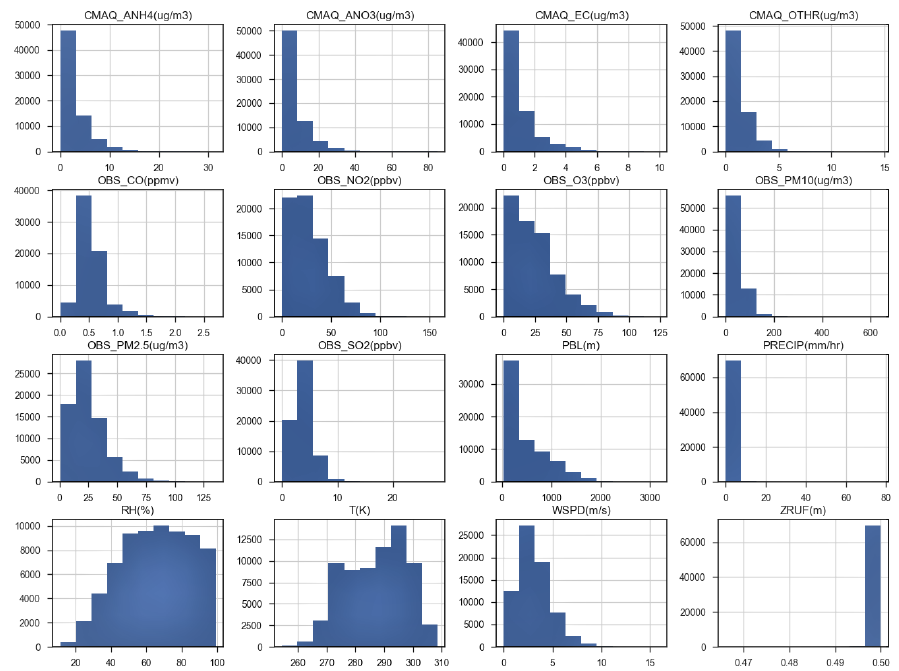
Figure 3. Data distribution for each